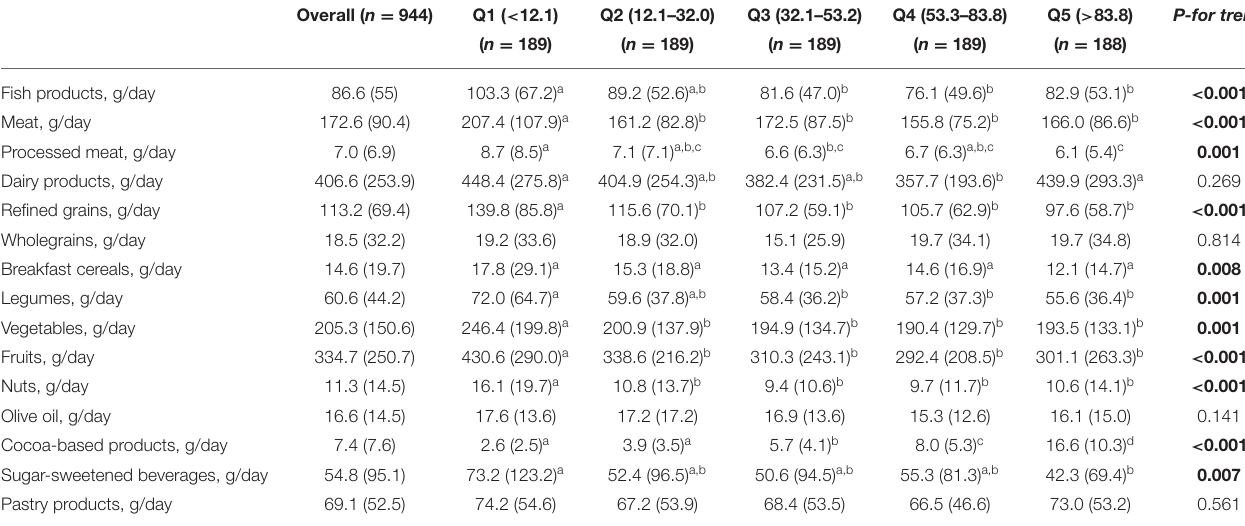
TABLE 2 | Dietary food intake of participants according to quintiles of flavonoids from cocoa-based products